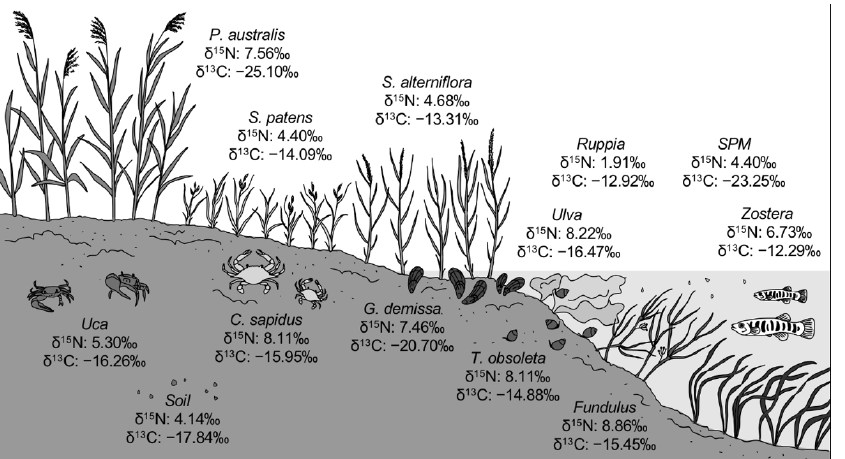
Figure 3. Species of primary producers, consumers, and particulates measured in this study. Values of nitrogen (δ 15 N) and carbon (δ 13 C) isotopes are averages between all measurements at 35 stations throughout Barnegat Bay. SPM stands for suspended particulate matter.